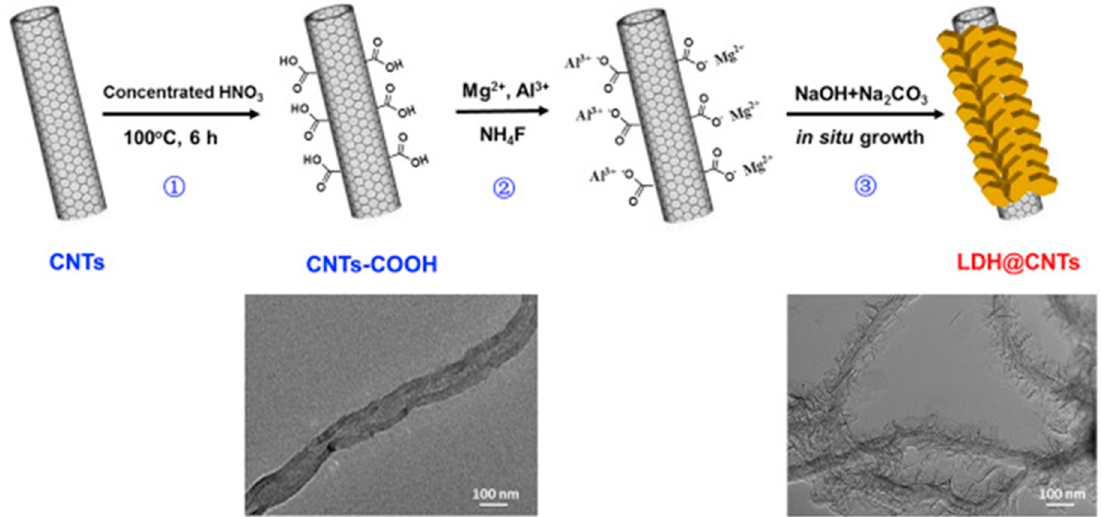
Figure 5. Preparation of LDH coated carbon nanotubes (LDH@CNTs). Reproduced with permission from Ref. [42].